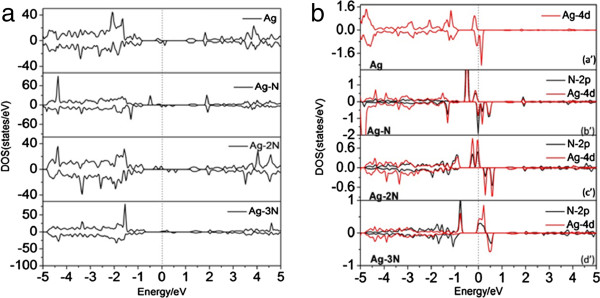
Total DOS (a) and PDOS (b) of Ag1, Ag1N2, Ag1N3,4, and Ag1N2,3,4 configurations.